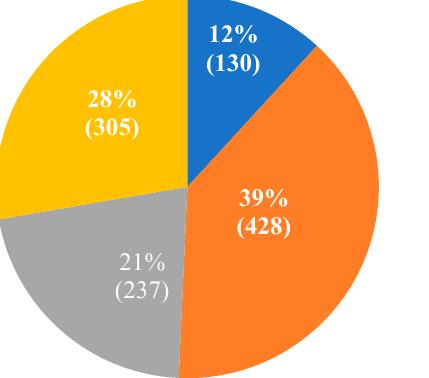
Figure 3. Flowchart of process adopted to review patents results; based on PRISMA Statement [68].